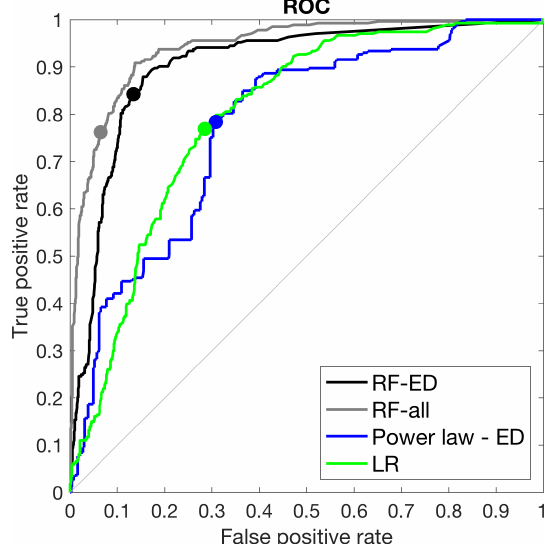
Figure 6. ROC curves for the hold-one-out validation technique for the four models. Circles correspond to the model performance when selected thresholds were based on TS